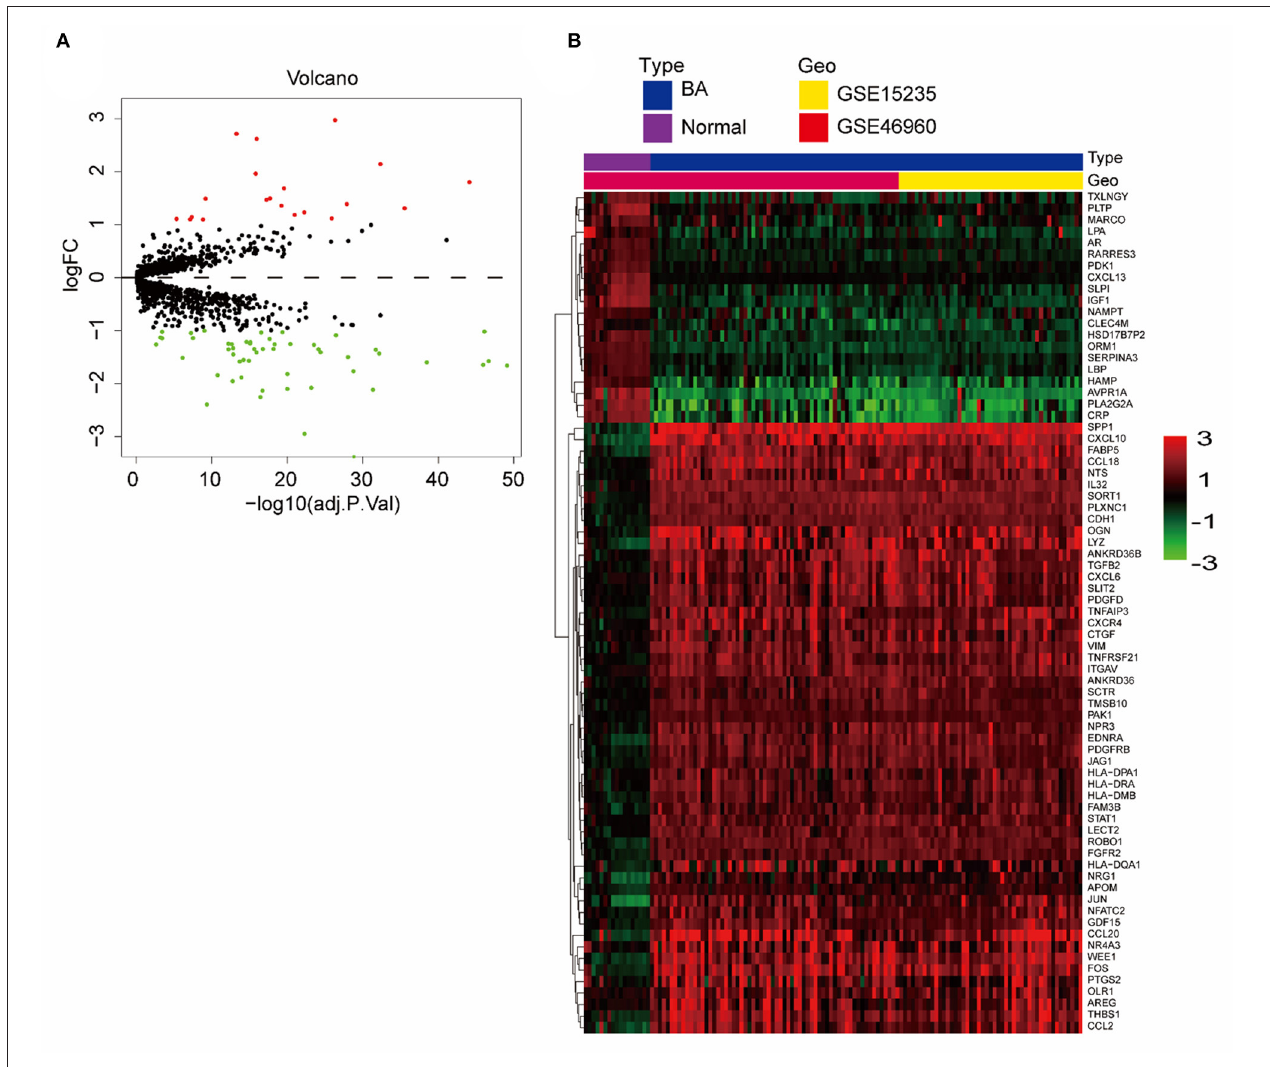
FIGURE 2 | DE-IGs between normal liver and BA. (A) The volcano plot of 73 DE-IGs between normal liver and BA. The red plots represent upregulated genes and the green plots represent downregulated genes. (B) The heatmap reflects the relative expression of DE-IGs in different individuals and the overall difference between the two